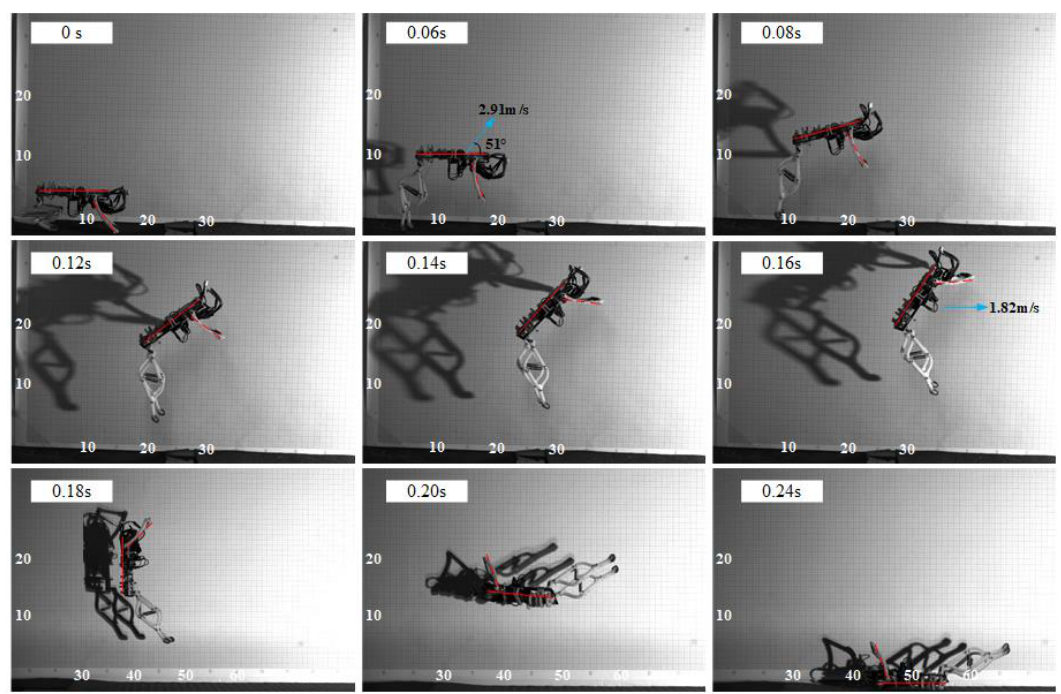
Figure 23. Motion sequence of jumping for gliding when the forelimbs are not actuated. The solid red lines denote the body, the dotted red lines denote the forelimbs, and the blue arrows denote the direction of velocity.